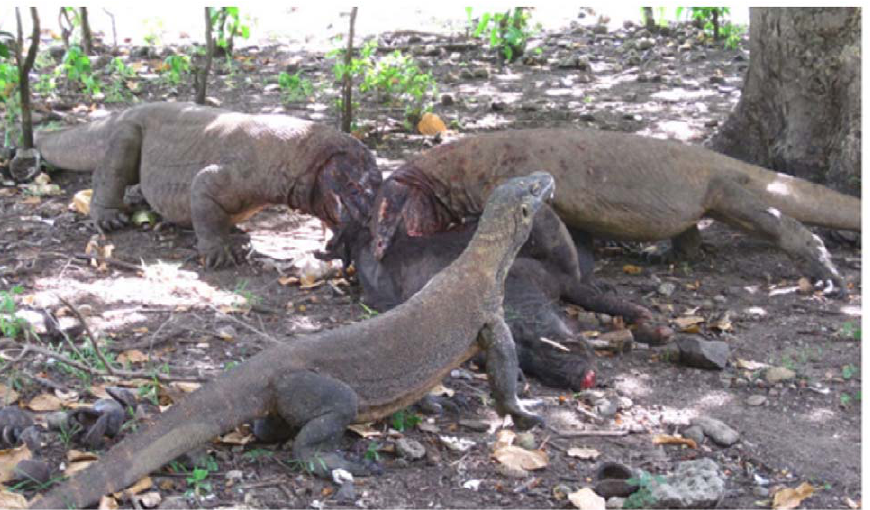
Figure 3. Communal feeding illustrated. Three dragons are feeding on a wild pig. The large prey size of Komodo dragons with overlapping lizard home range generally precludes a single lizard from consuming its large prey alone. Multiple or shared feeding facilitates spread of infectious bacteria between lizard mouths. (Photo by Achmad Ariefiandy.)